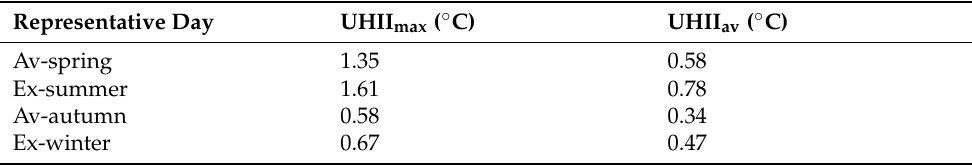
Figure 11. Potential temperature map of the simulated area for ex-winter at the height of 3 m. Table 7. UHII max and UHII av at the height of 3 m of the north receptor. Representative